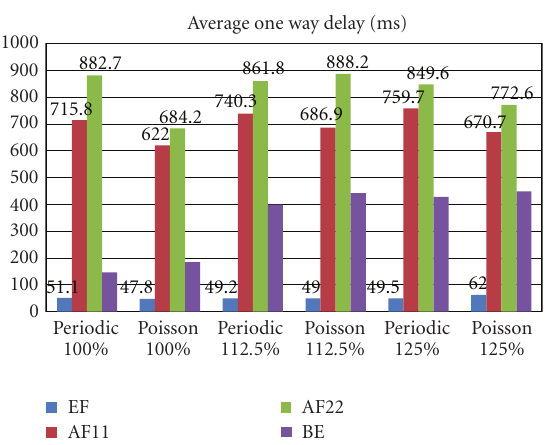
Figure 16: Average one way Delay graph.